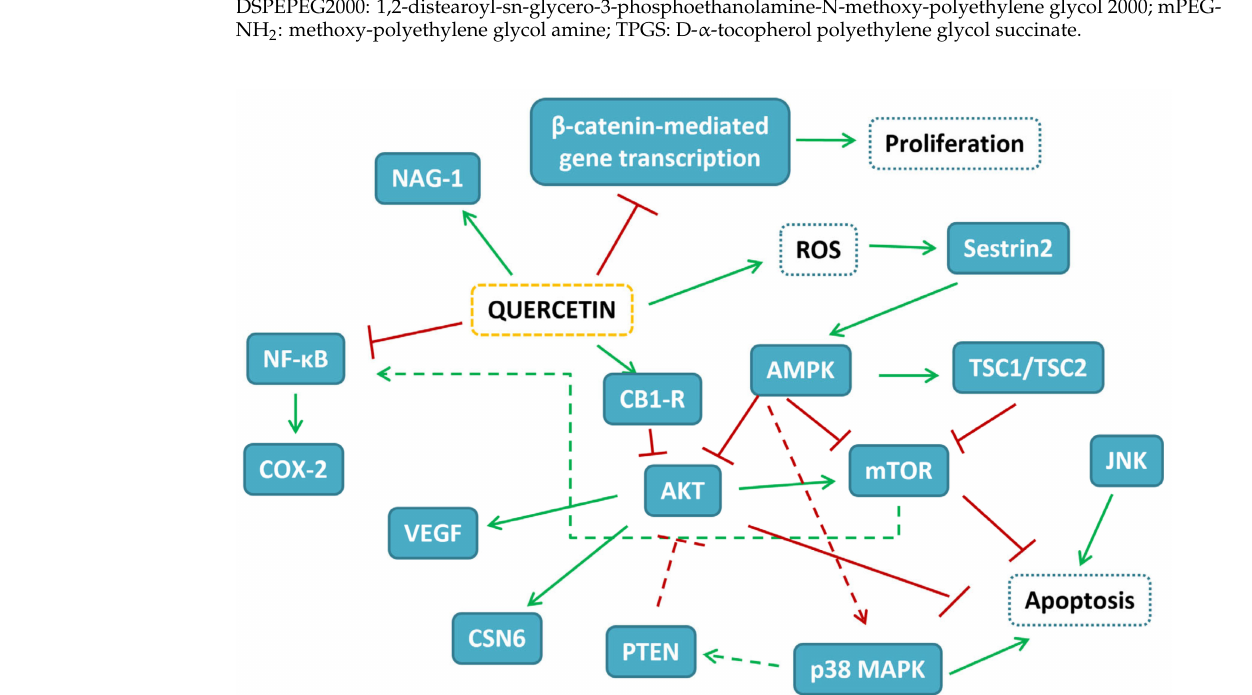
Figure 2. Map of the interactions of quercetin in CRC experimental models. In blue-filled boxes, the protein influenced by quercetin treatment are reported, while blue-dashed boxes indicate cellular events. Red T-shaped lines correspond to inhibition, while green arrows correspond to